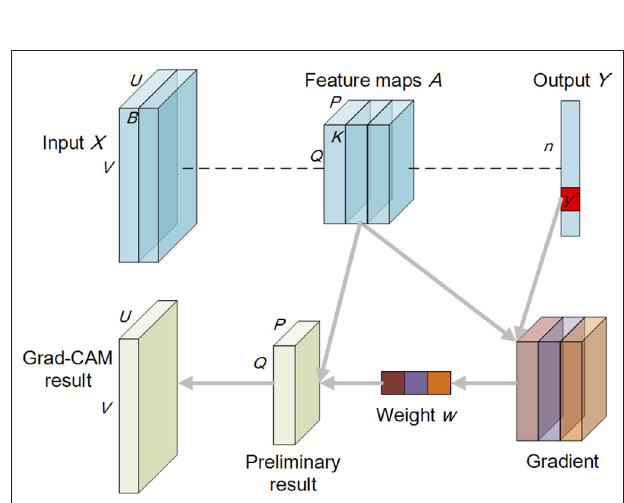
make decisions properly (i.e., black-box models) (as displayed in